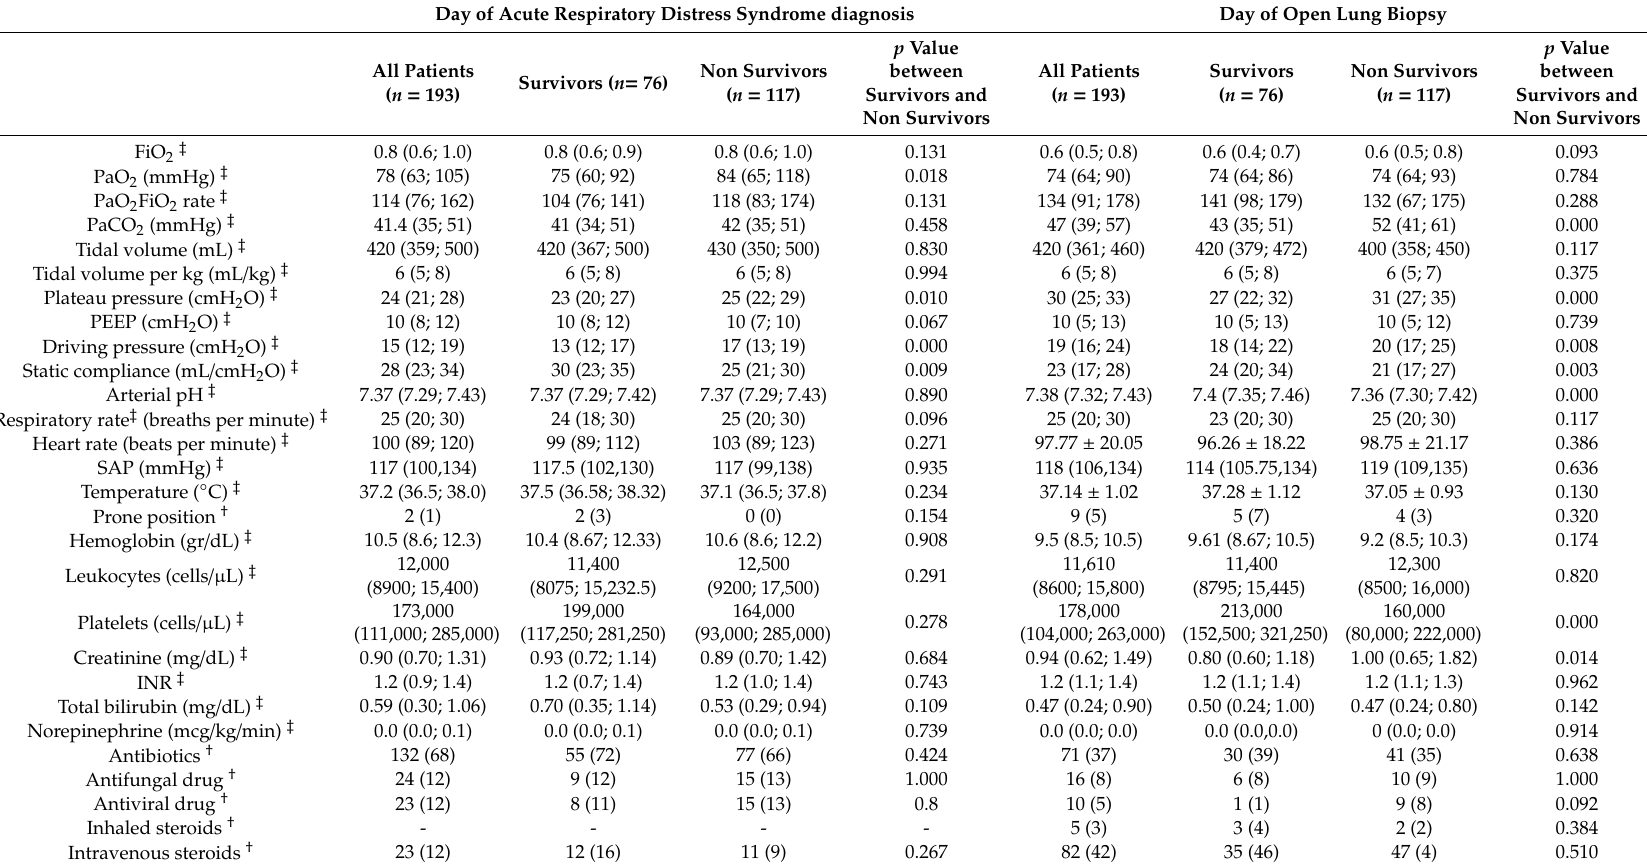
Table 7. Bivariate analysis for mortality on the day of ARDS diagnosis and the day of